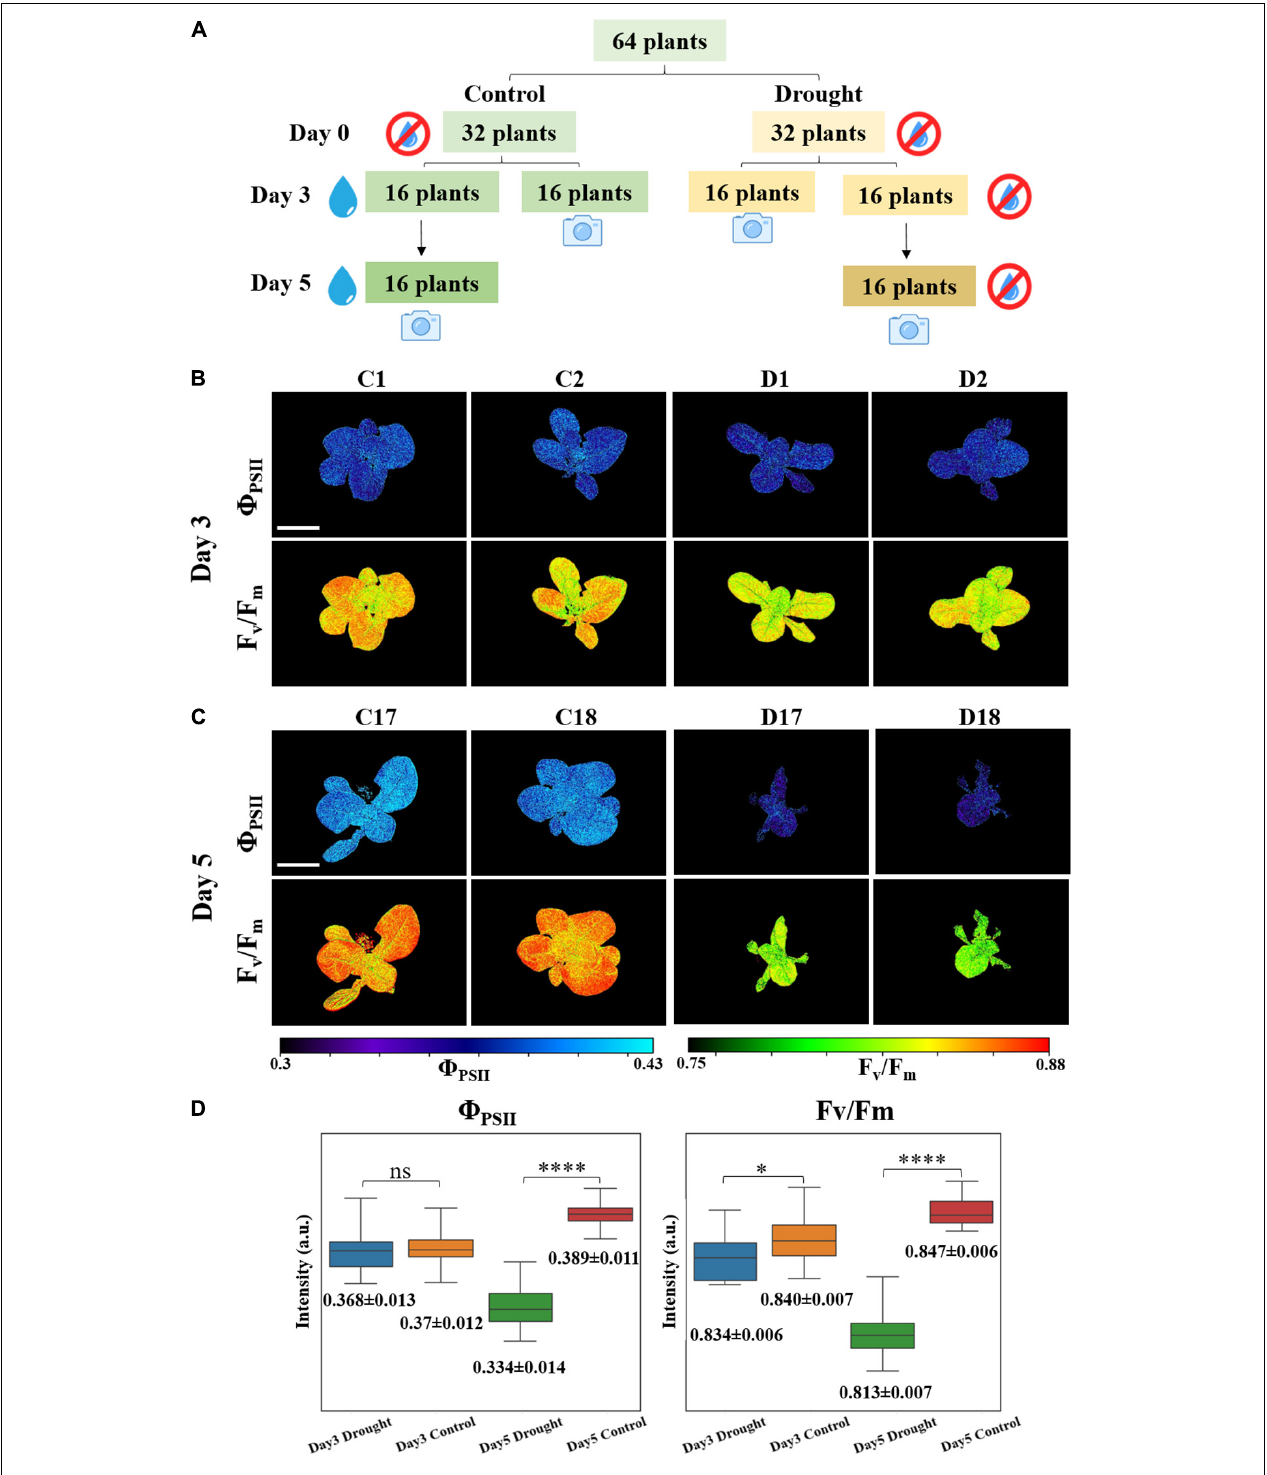
FIGURE 2 | (A) Plants drought treatment for photosynthetic activity measurement. Examples of (B) day 3 and (C) day 5 fluorescence images of (cid:56) PSII and F v /F m . C represents for control group and D represents for drought group. The scale bar represents 5 cm. (D) Boxplots: mean values of 5,000 effective pixels randomly selected from (cid:56) PSII and F v /F m images of the 16 plants in drought and control groups at days 3 and 5. Box is defined by 25th, 50th, and 75th percentiles. Top and bottom bars are maximum and minimum pixel intensities. Numbers below are mean values ± standard deviations (SDs). Student’s t -test were conducted to compare the difference of drought and control groups based on the values of p ( n = 16, ns: p > 0.05, ∗ p < 0.05, ∗∗∗∗ p < 0.0001).